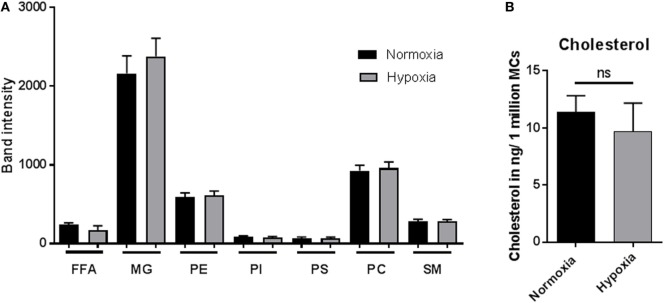
Lipid alteration and cholesterol content. (A) Mast cells (MCs) (3 × 106 cells/ml) were incubated under hypoxia or normoxia for 3 h, and their lipid composition was analyzed by high performance thin layer chromatography (n = 3 independent experiments in duplicates) (A): free fatty acids (FFAs), monoacylglycerols (MGs), phosphatidylethanolamine (PE), phosphatidylinositol (PI), phosphoserine (PS), phosphatidylcholine (PC), and sphingomyelin (SM). No differences could be observed comparing hypoxia and normoxia. (B) Cholesterol content (nanogram per 1 × 106 MCs) was analyzed via HPLC (n = 4 independent experiments in duplicates). The cellular cholesterol level was not affected.